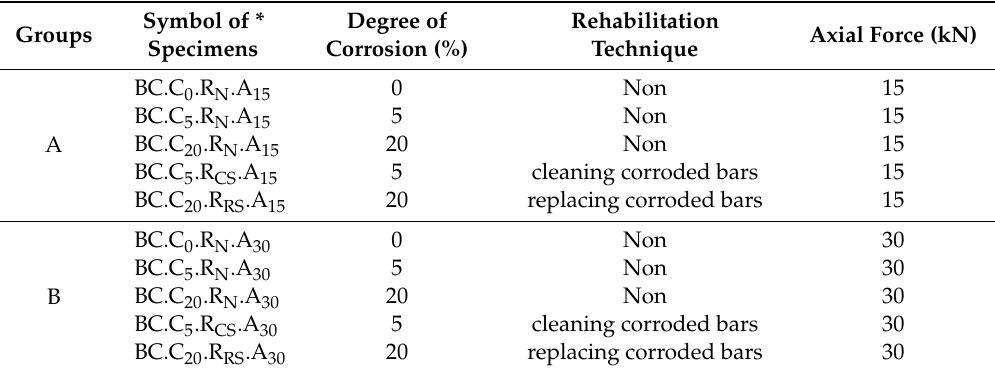
Table 1. Designation and details of tested